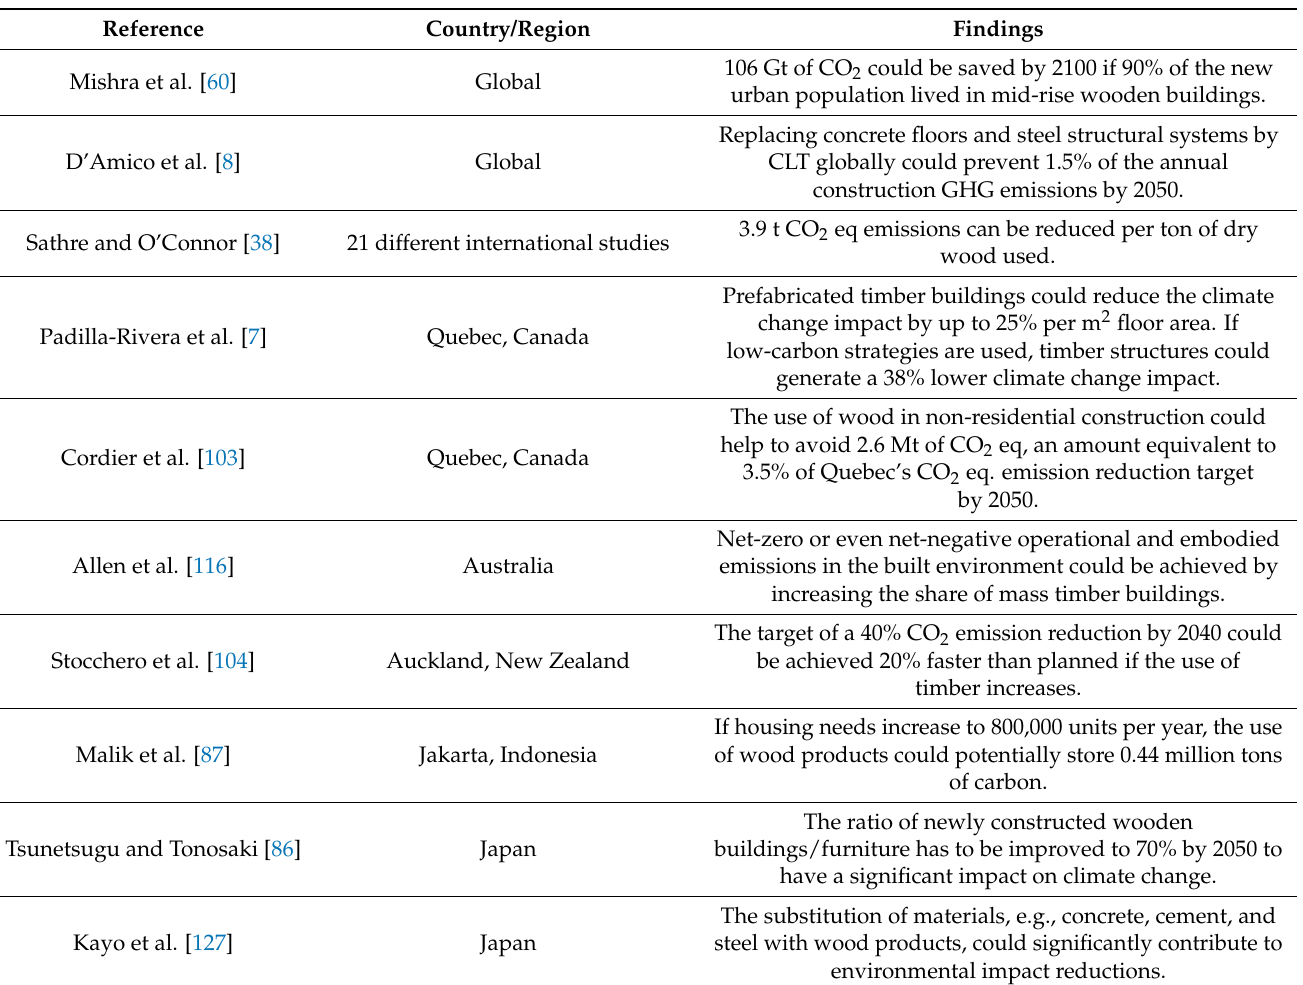
Table 5. Studies on the potential reduction in GHG/CO 2 emissions caused by the increased use of wood in the building